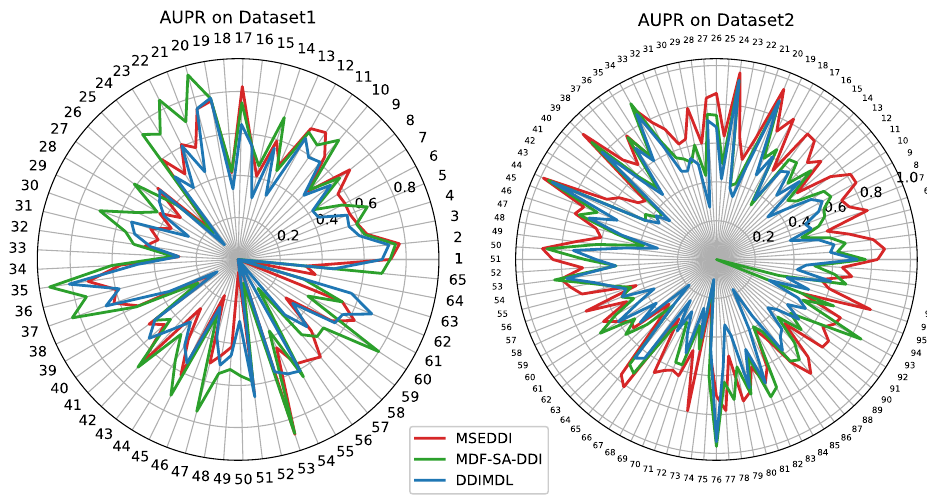
Figure 2. The AUPR of partial baselines for each event.